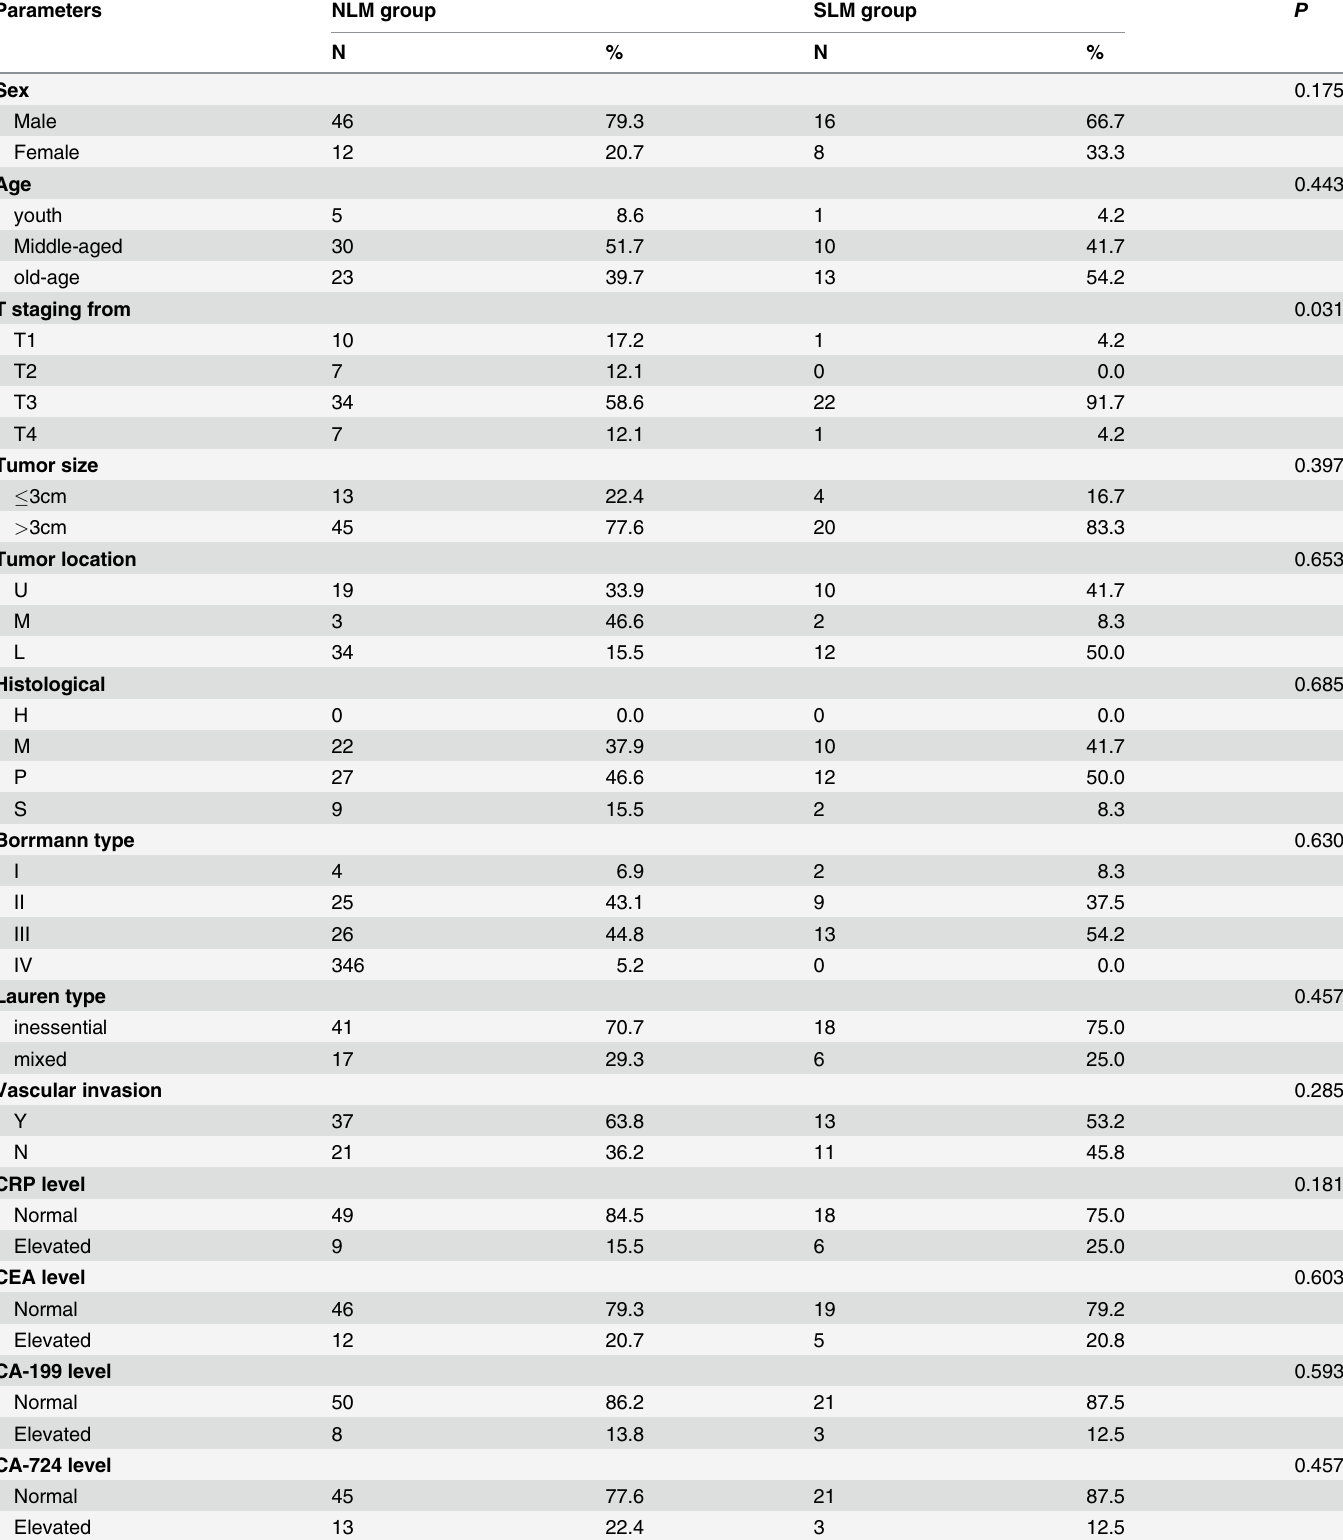
Table 4. The clinicopathologic features between no skip SLM and skip SLM.